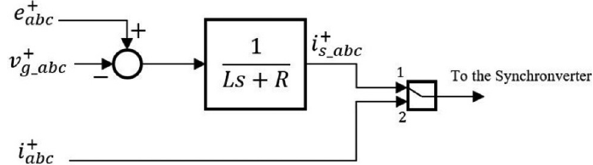
Figure 4: Synchronization process using the instantaneous values of the positive - sequence